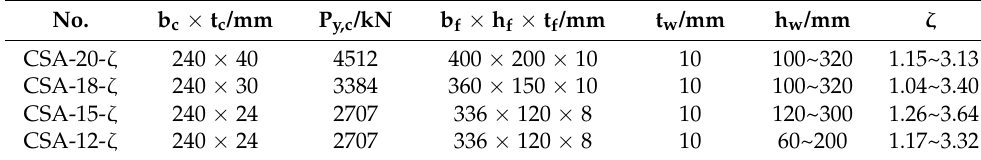
Table 1. Key geometric dimensions of different numerical examples of the